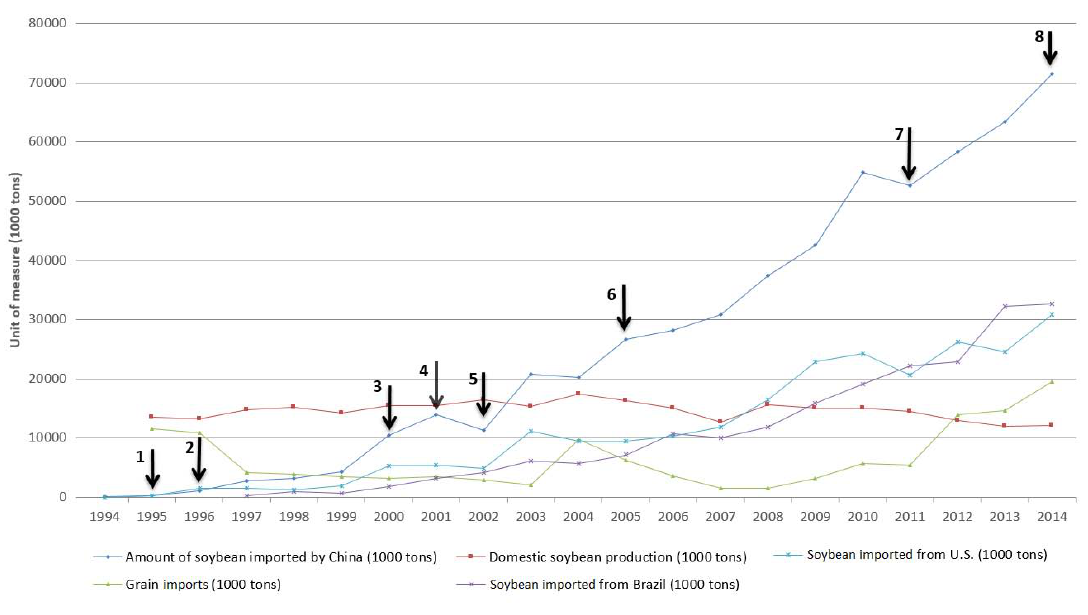
Figure 2. China’s soybean production and import, and critical time points. Each arrow in the figure highlights a key event in the Chinese policy or economy with impact on soybean imports (see text for details). Data source: